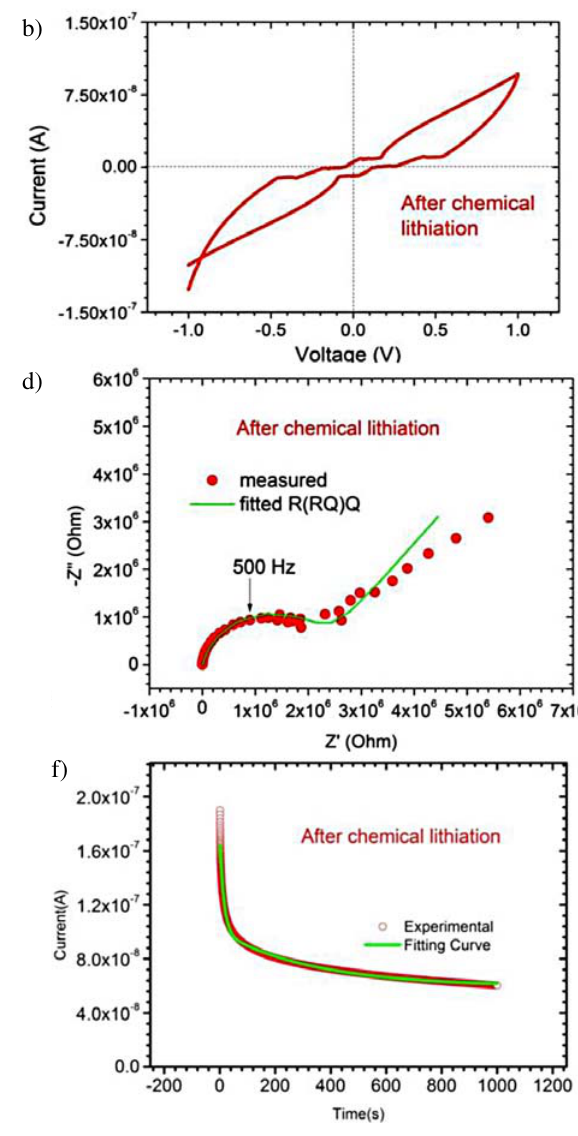
Figure 8. The IV (a, b), IS (c, d) and ITIC (e, f) measurement results of the LiF-Ti (LiF:Ti = 88:1) nanocomposite thin film at room temperature be- fore and after chemical lithiation. The pristine Ti-poor LiF-Ti sample shows a relative low electric conductivity due to the Ti deficiency. Thus the signal of IV curve was affected by